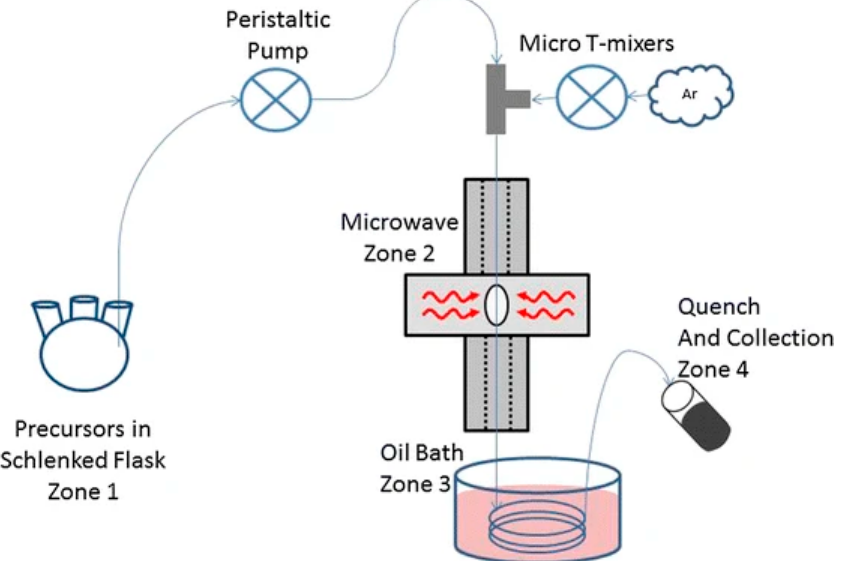
Figure 7. MWCFR used for the synthesis of CIS QDs. Precursor solutions are prepared in an air-free three-necked flask on a Schlenk line, and peristaltic pumps are used to move the solution through polytetrafluoroethylene (PTFE) tubing into the microwave heating zone, through an oil heating bath, and finally into the sealed collection vial under N 2 gas [64].